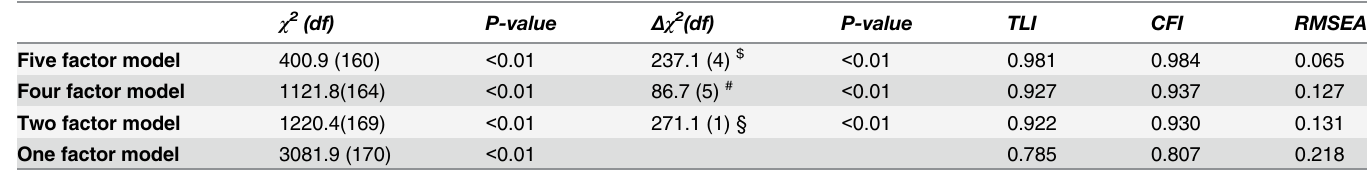
Table 3. χ 2 difference tests and model fit indices for the models tested for the total group (THA and TKA). χ 2